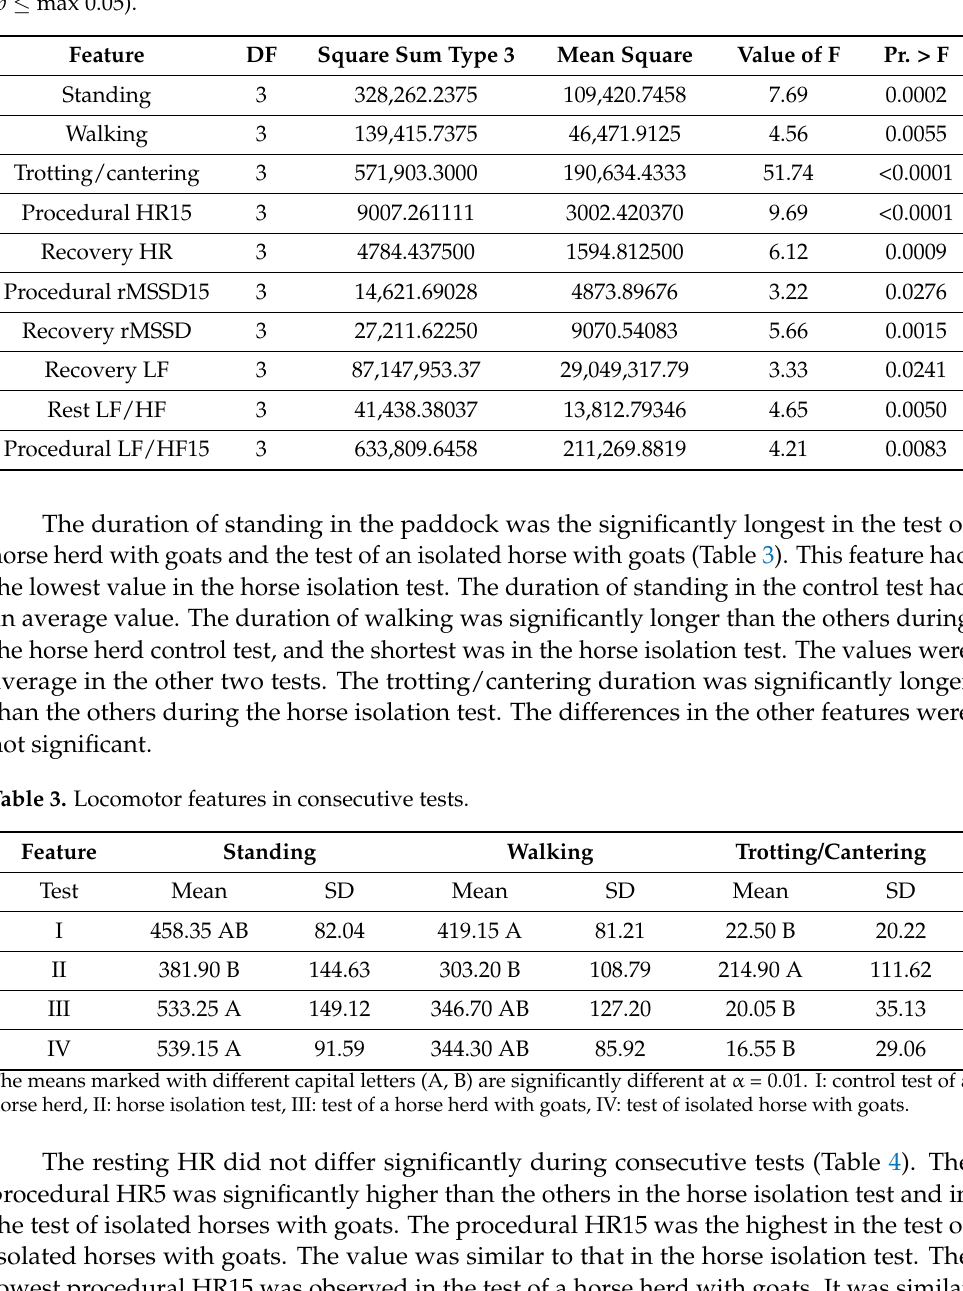
Table 2. The features for which a significant impact of the subsequent test factor was observed ( p ≤ max 0.05).